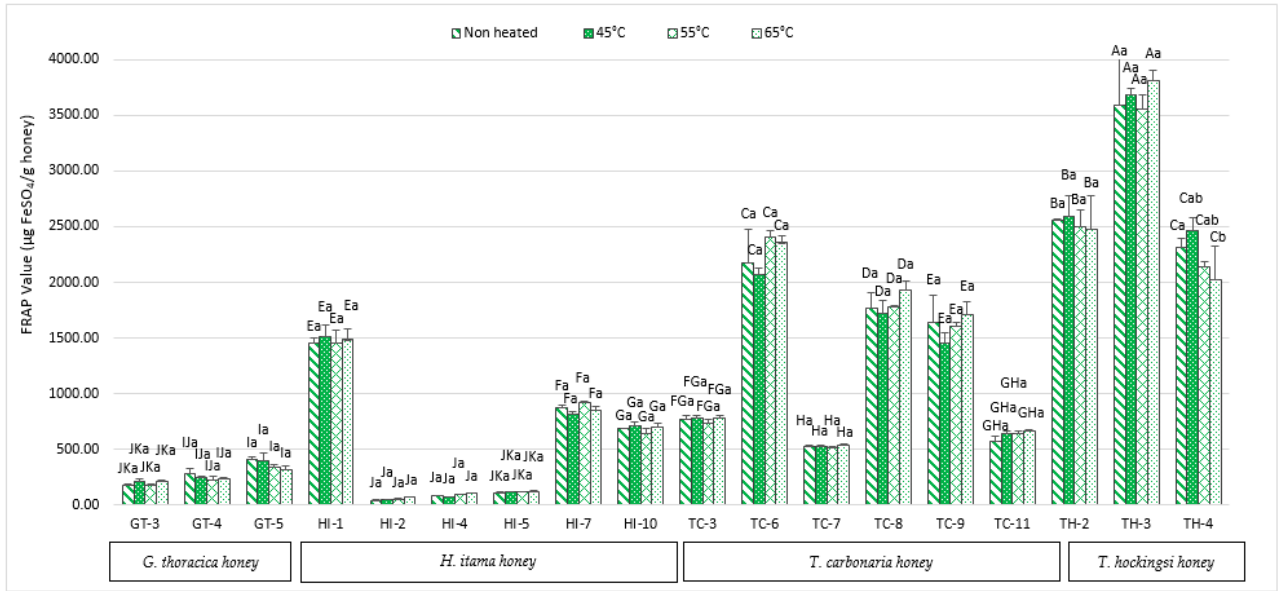
Figure 4. Ferric reducing antioxidant power value of Malaysian and Australian stingless bee honey. Different superscripts, a and b, indicate significant differences ( p < 0.05) between the temperatures, and different superscripts, A – J, indicate significant differences ( p < 0.05) between the stingless bee honeys.